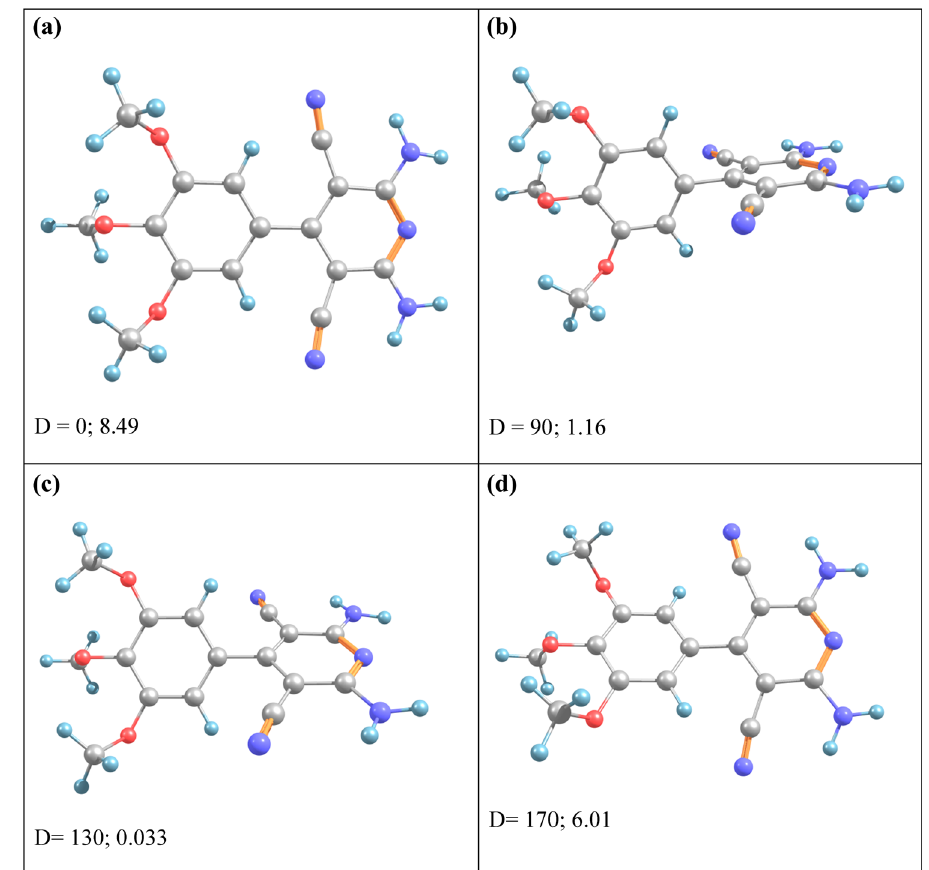
Figure 7: Possible conformers of DTPP. ( a ) D = 0; 8.49, ( b ) D = 90; 1.16, ( c ) D = 130; 0.033, and ( d ) D = 170;